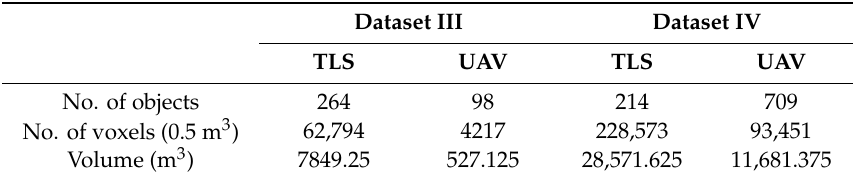
Table 8. Summary of detected occlusions within the power lines corridor. The corridor for Dataset III was 5 m distance from the power lines, while for dataset IV it was 15